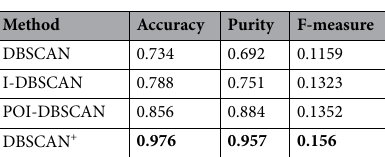
Table 4. The external metrics of other indicator. The bold indicates that the algorithm proposed in this paper is better than other algorithms.